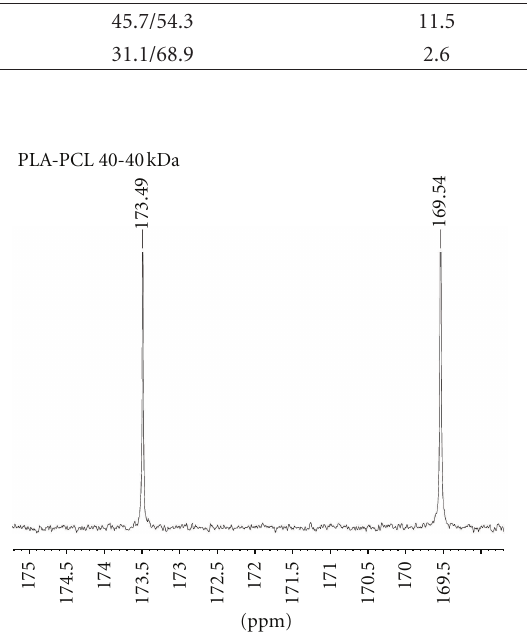
Figure 4: 120–170 ppm region of 13 C NMR spectrum of triblock copolymer PTMC-PLA-PTMC 20-40-20kDa, synthesised without protector (A) and with protector (B).